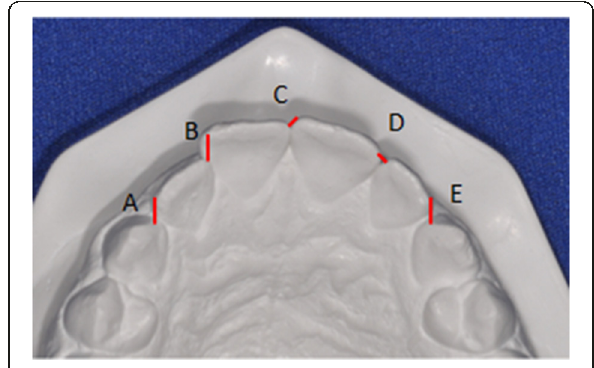
Fig. 1 Modified Little ’ s irregularity index for the maxillary arch/ A +